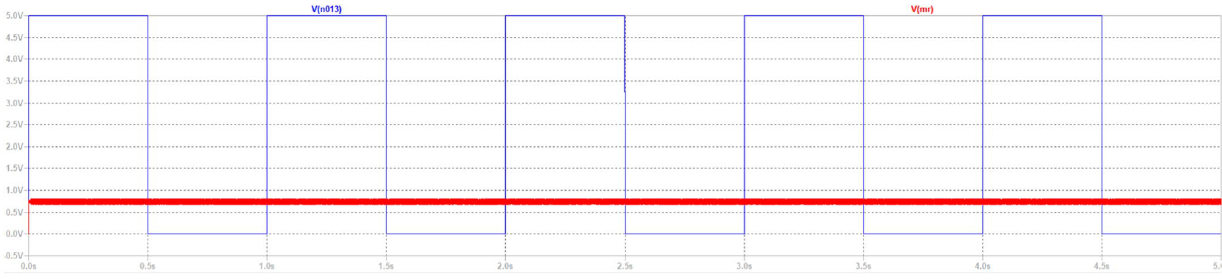
Fig. 18 Message is not decoded if the memristors values are changed beyond the tolerance